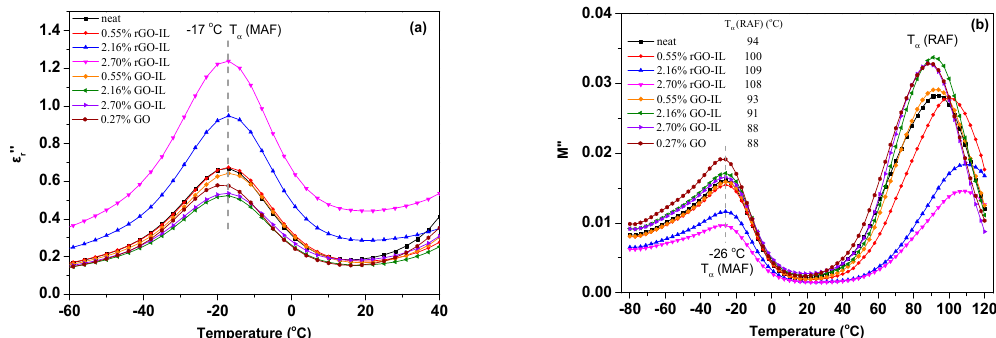
Figure 13. Imaginary part of relative permittivity ( ε r ”) ( a ) and dielectric modulus (M”) ( b ) as a function of the temperature of neat P(VDF-CTFE) and composites containing GO, GO-IL, and rGO-IL ( f = 1 kHz, the first heating run). Note that the peak position and intensity from the first heating run is the same as the one from the second heating run).